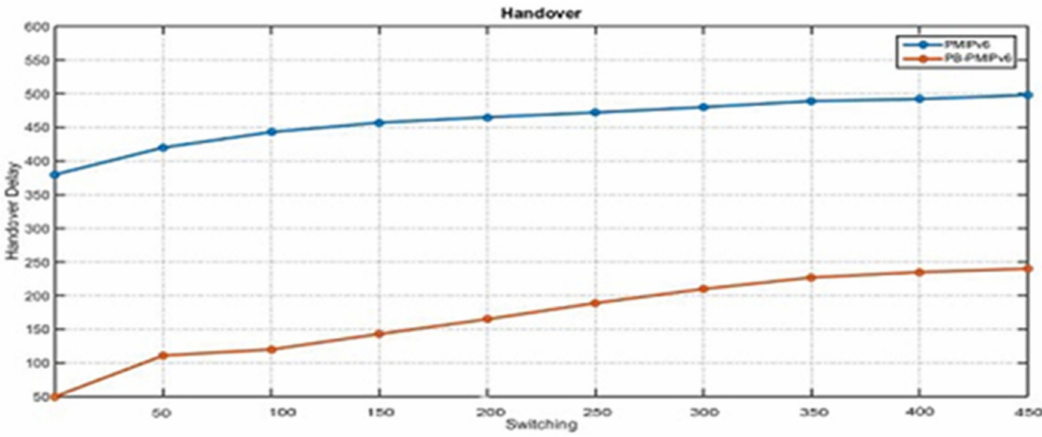
Figure 9. Comparison of handover delays during handover.